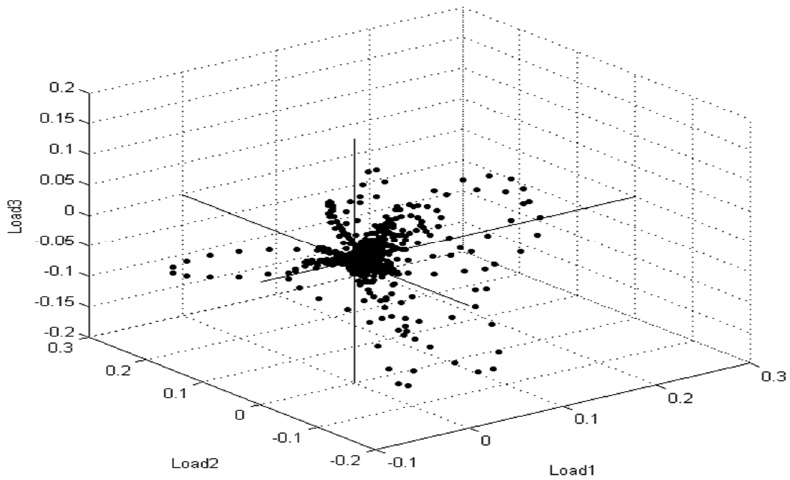
Figure 5. Multiple spectra for S. aureus strains collected from patient cases are depicted in the PCA density. The intensity rate of single signals is shown by a single point. The signals were changed until they reached the loading value that was compatible with loading 1, loading 2, and loading 3.